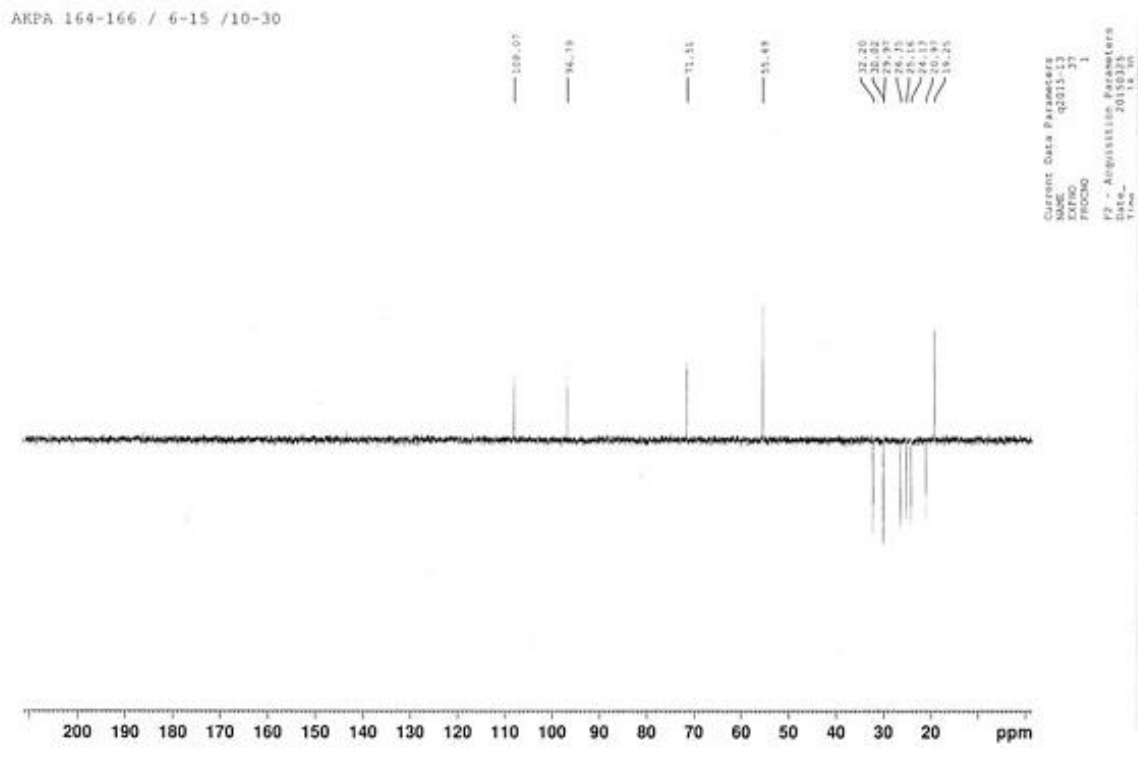
Figure A4. DEPT spectrum of isolated